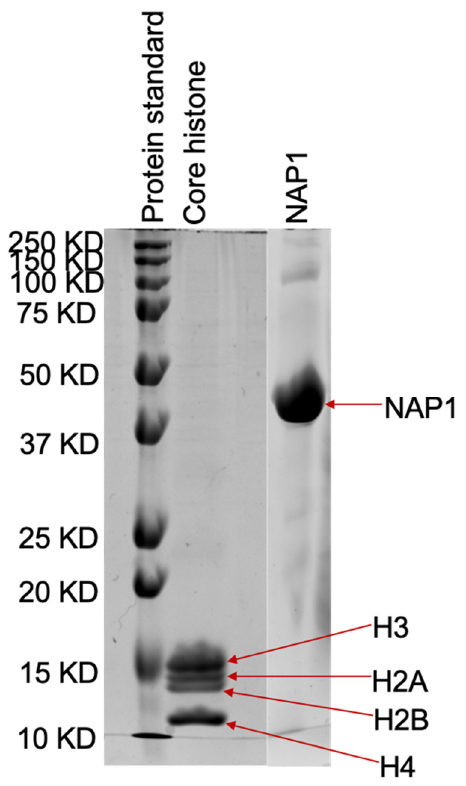
Figure 6. SDS-PAGE analysis of core histones and NAP1. Approximately 7.2 µ g of core histones and 40 µ g of NAP1 were loaded on of 15% gel and were stained with coomassie-blue after electrophoresis. The numbers on the left side indicate the molecular weight of marker proteins.